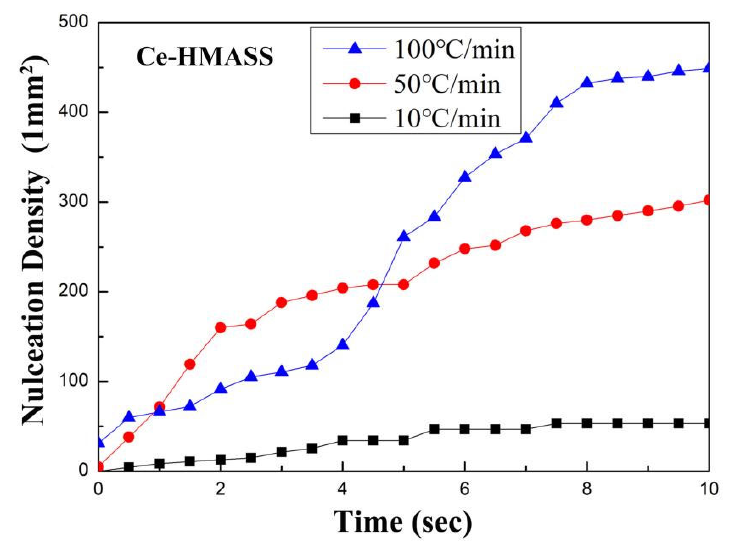
Figure 2. The evolution of nucleation sites’ density under different cooling rates.